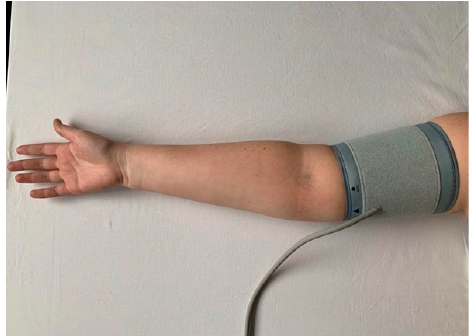
Figure 1. Proximal location of the cuff.